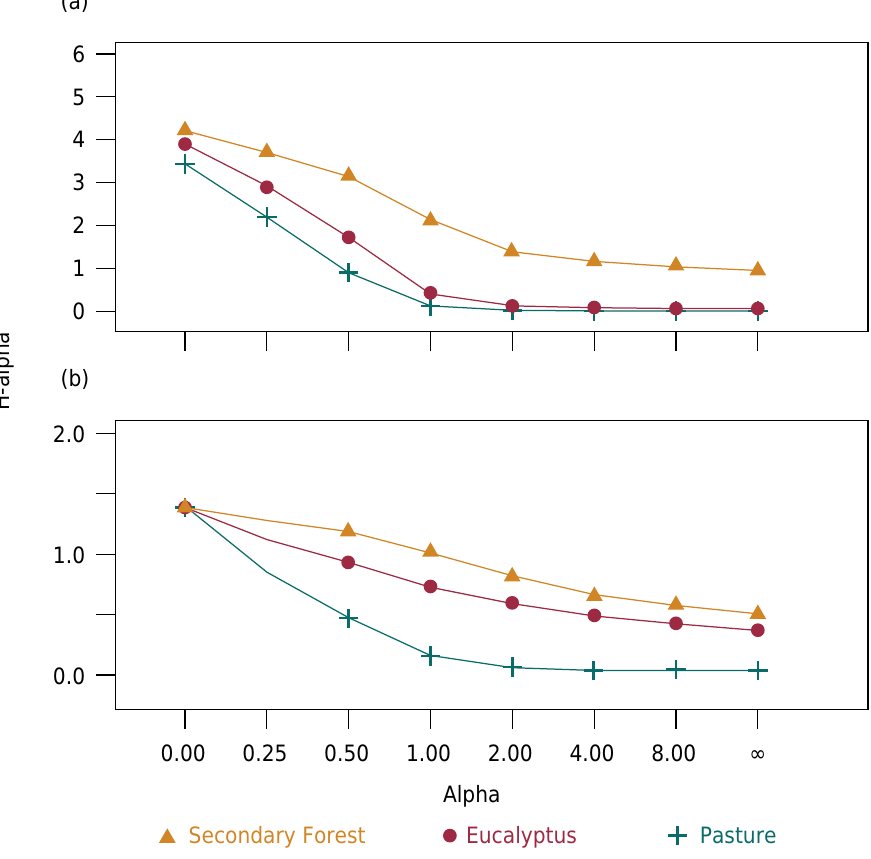
Figure 3. Rényi diversity profiles in the different LUS in Marabá-PA. Family diversity profile (a), functional groups (b) diversity profiles. α = 0: Family richness; α = 1: Shannon-wiener index; α = 2: Simpson index; α = ∞ (infinite): Berger-Parker